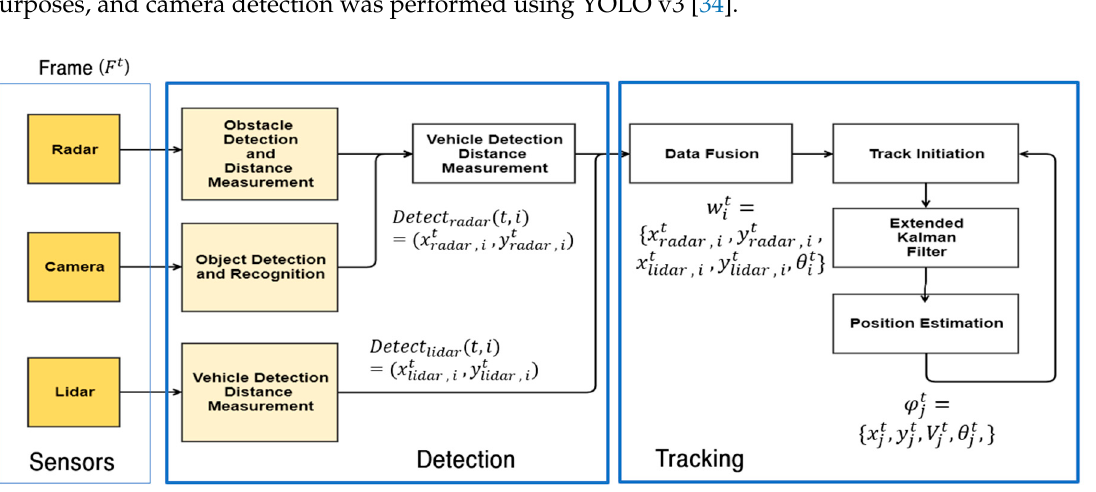
Figure 6. System structure.